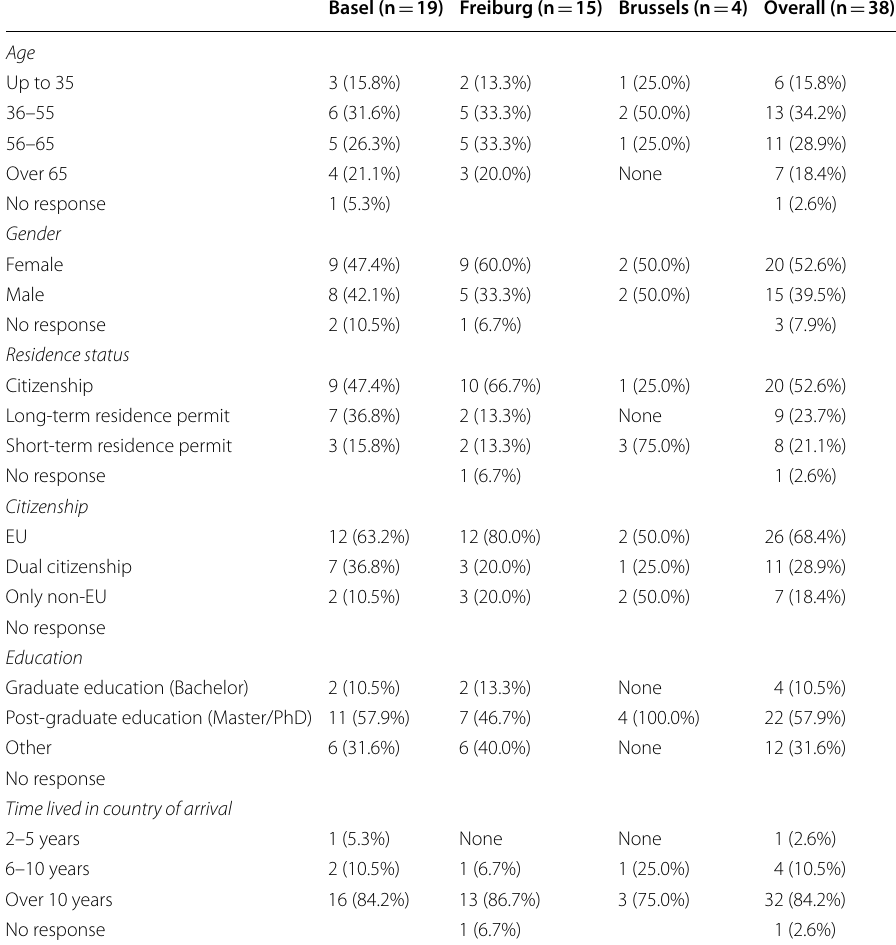
Table 1 Demographic data of the